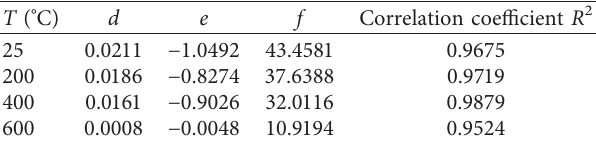
Figure 13: Relationship between dynamic peak strain and incident energy. Table 3: Parameter values of dynamic peak strain and incident energy.